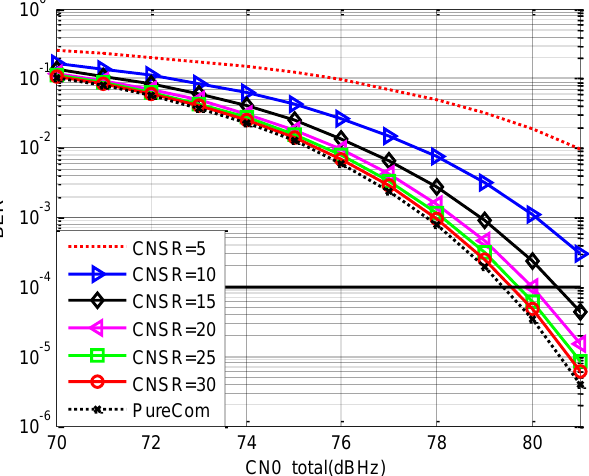
CN under different CN S R . Figure 7. Bit error rate (BER) under versus CN 0 total under di ff erent CNSR t o t a l